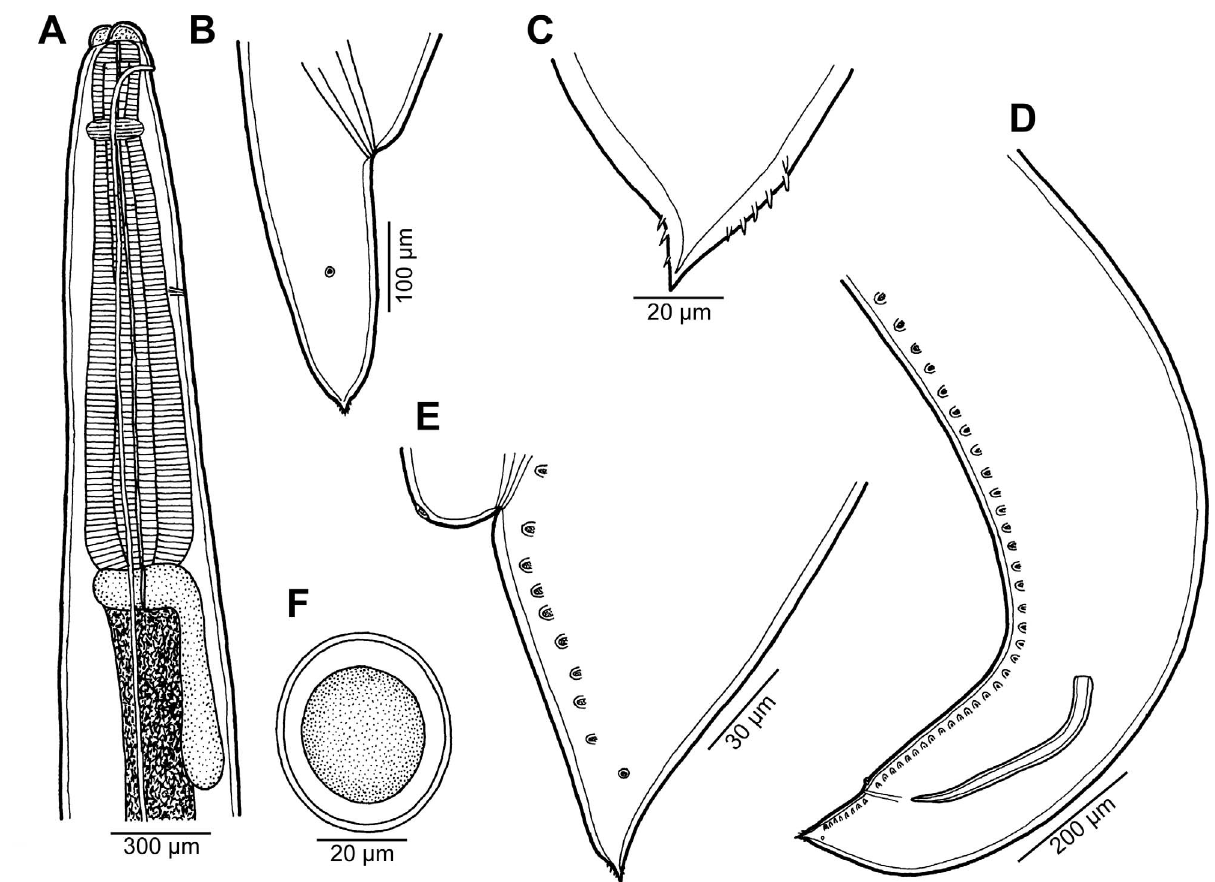
Figure 1. Raphidascaris ( Ichthyascaris ) spinicauda n. sp. ex Caesio cuning . (A) Anterior end of female, lateral view; (B) tail of female, lateral view; (C) tail tip of female, lateral view; (D) posterior end of male, lateral view; (E) tail of male, lateral view; (F)